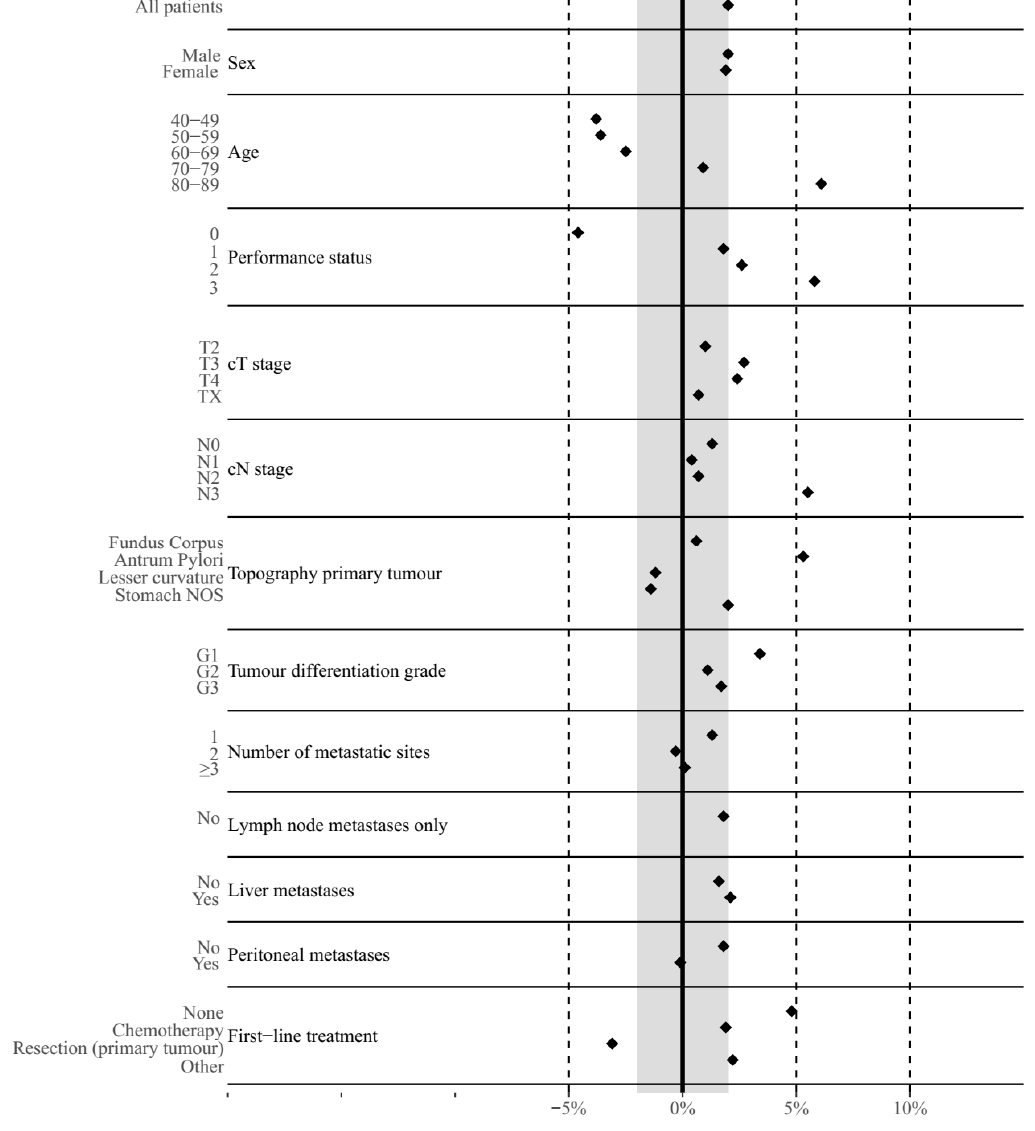
Figure 4. Mean di ff erences between predicted and observed six-month overall survival for gastric Figure 4. Mean differences between predicted and observed six-month overall survival for gastric cancer patients by patient subgroups. Values > 0% indicate an overestimation and values < 0% indicate cancer patients by patient subgroups. Values >0% indicate an overestimation and values <0% indicate an underestimation in overall survival. The grey band represents the mean di ff erence between predicted an underestimation in overall survival. The grey band represents the mean difference between and observed six-month overall survival for the entire gastric cancer predicted and observed six-month overall survival for the entire gastric cancer cohort.